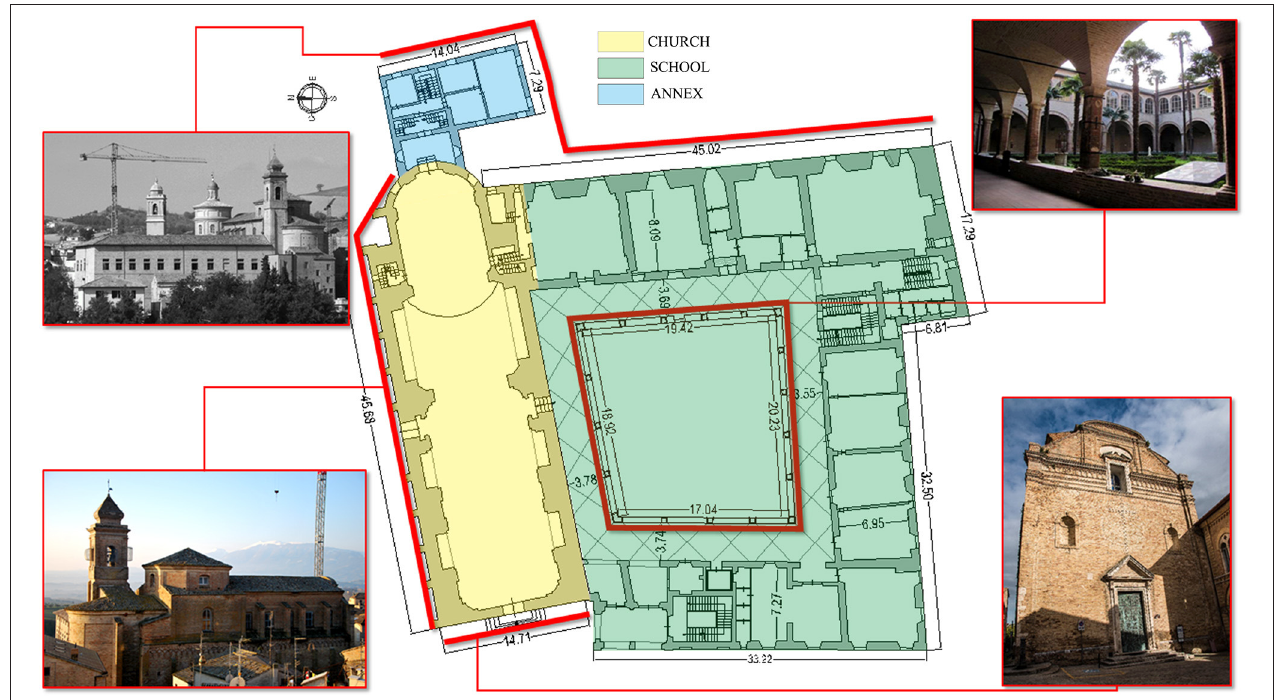
FIGURE 1 | General view of Sant’ Agostino’s